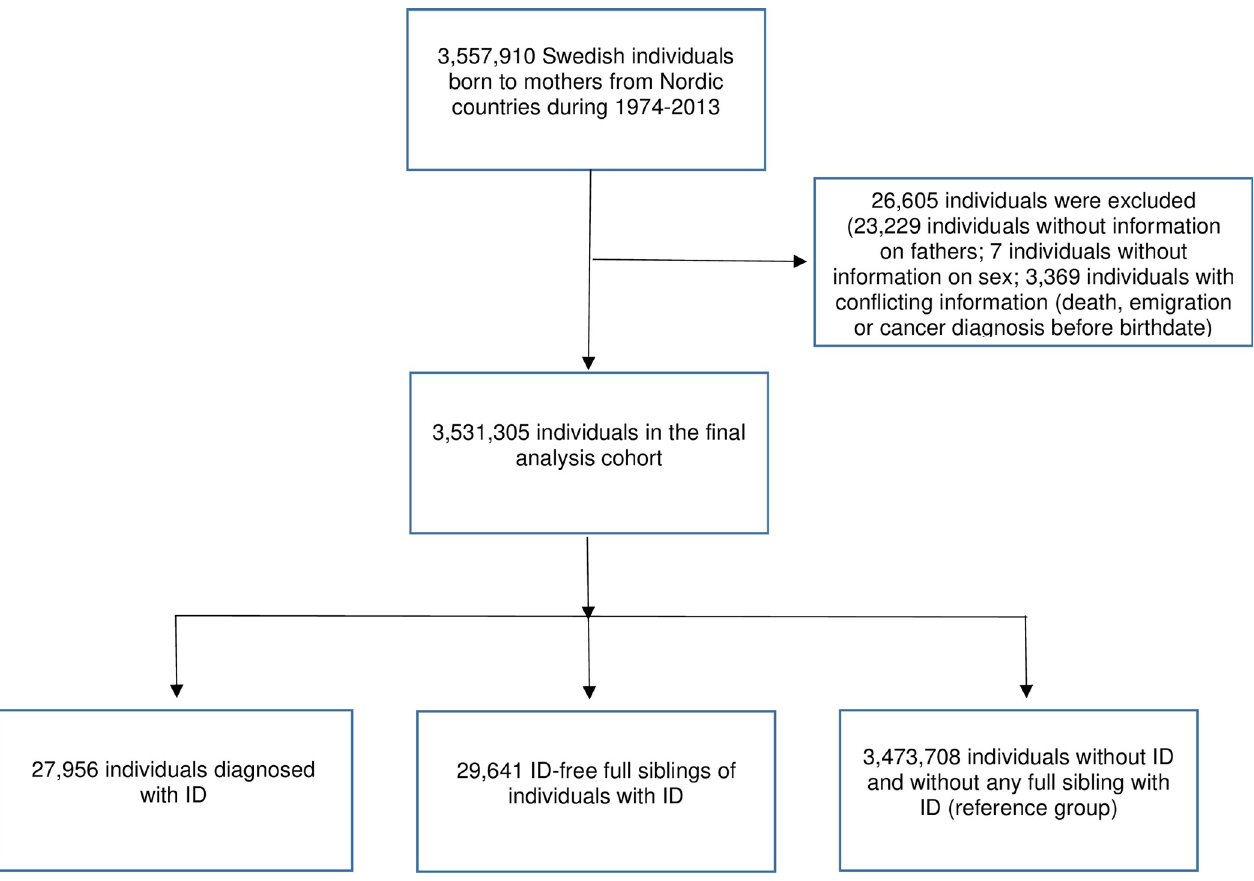
Fig 1. Flow chart describing inclusion and exclusion of study participants. ID, intellectual